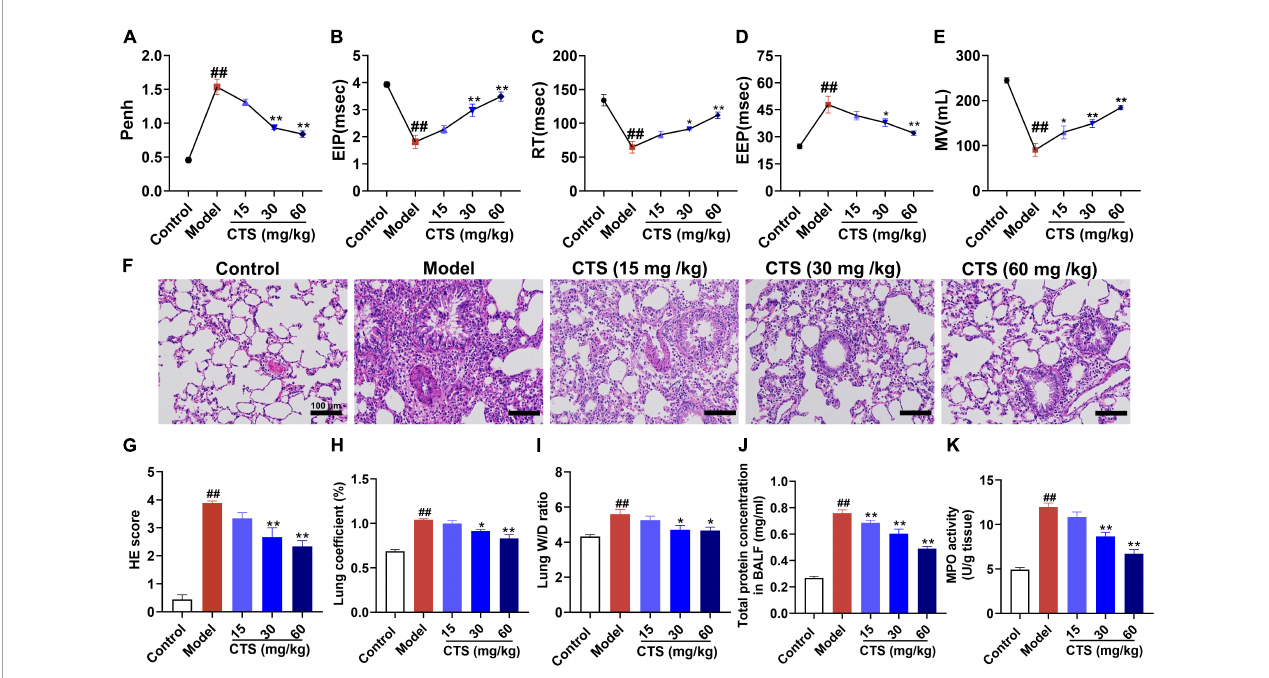
FIGURE1 Cryptotanshinone (CTS) ameliorates LPS-induced acute lung injury in rats. LPS was used to induce in vivo ALI and CTS at different concentrations was administrated to rat. Representative parameters of mice pulmonary function: (A) enhanced pause (Penh), (B) end-inspiratory pause (EIP), (C) relaxation time (RT), (D) end-expiratory pause (EEP), (E) minute ventilation volume (MV), n = 6. (F) Representative HE staining results of lung histopathological changes, scale bar: 100 µ m, n = 6. (G) Lung histopathological score, n = 6. (H) Lung coefficient (%) changes in each group, n = 8. (I) Wet-dry weight ratio of right lung (Lung W/D ratio) in rats, n = 6. (J) Total protein concentration in BALF, n = 5. (K) The MPO activity level in the lung tissues was measured, n = 6. ## P < 0.01 vs. the control group; * P < 0.05, ** P < 0.01 vs. the Model